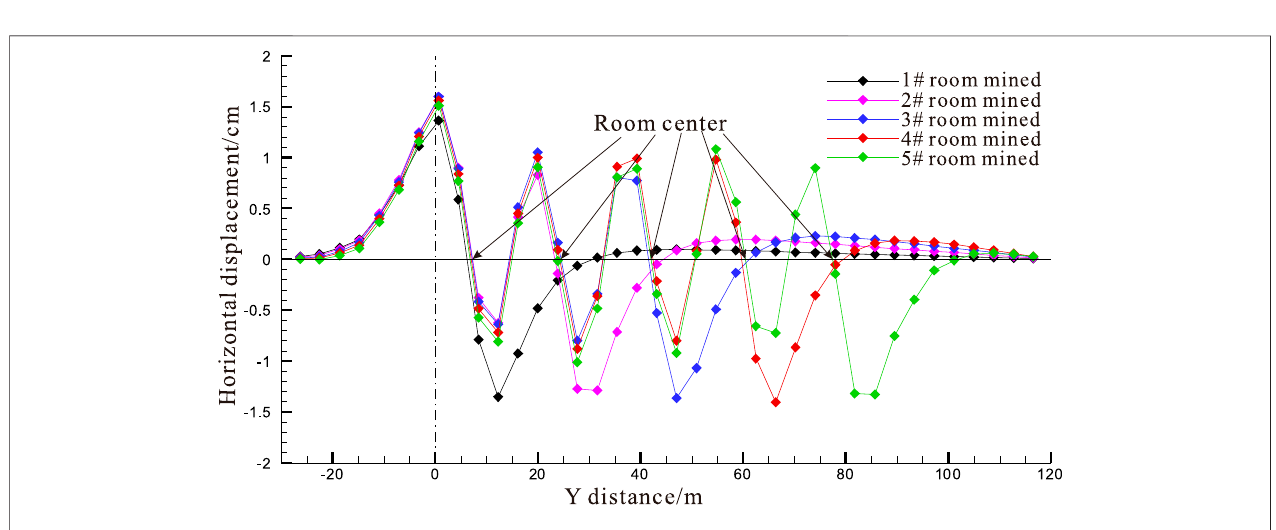
FIGURE 7 | Horizontal displacement curves of the roof during stoping the rooms 1# to 5#.